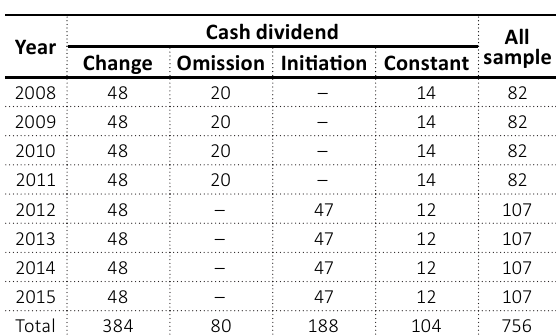
Table 2. Distribution frequency of the dividend